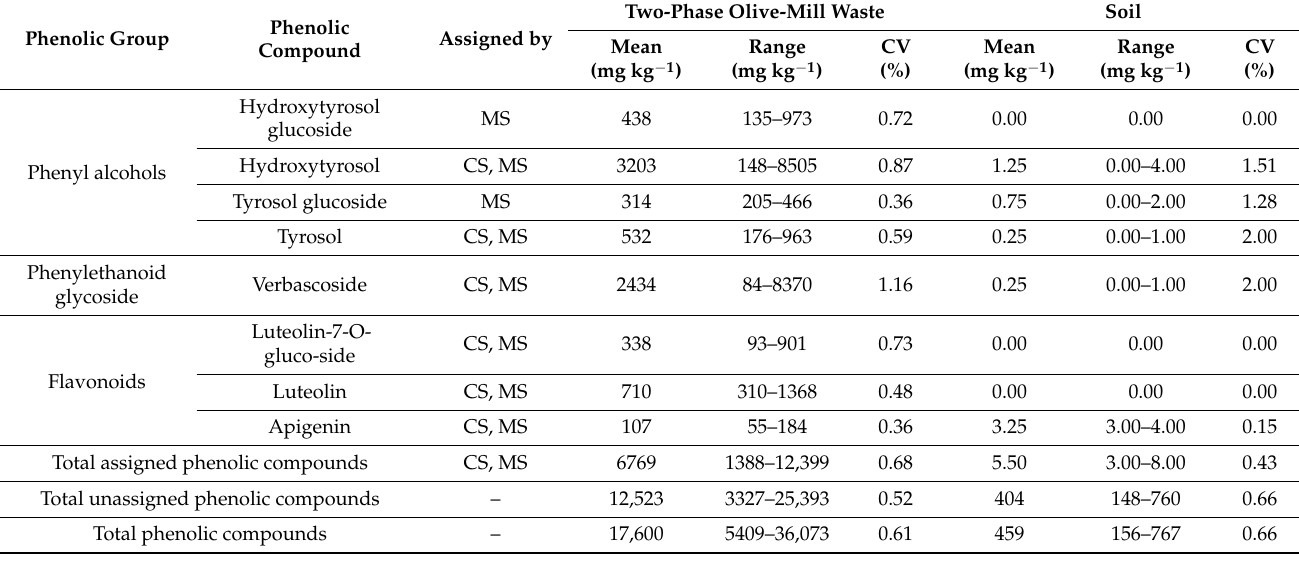
Table 2. Main phenolic compounds in the two-phase olive-mill waste and the olive grove soil. All data are expressed using the response factor for tyrosol at 280 nm. Phenolic compounds are assigned based on mass spectrometry (MS) and/or chemical standards